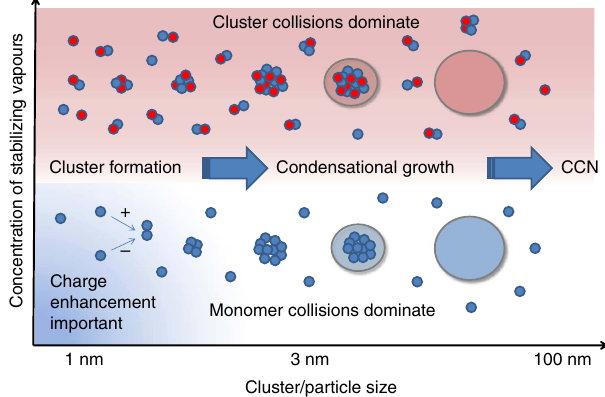
Figure 4 | Conceptual summary. Schematics of the factors affecting the growth rate of clusters and particles in a sulphuric acid-driven system. In the presence of vapours which are effective in stabilizing sulphuric acid clusters (for example, ammonia, amines, organic vapours) cluster collisions may assist the growth of clusters to nano-particles and up to CCN, while the enhancement due to electric charge is significant only for the initial steps of cluster formation when the concentrations of stabilizing vapour(s) are low. The absolute concentration required for significant cluster formation depends on the strength of the